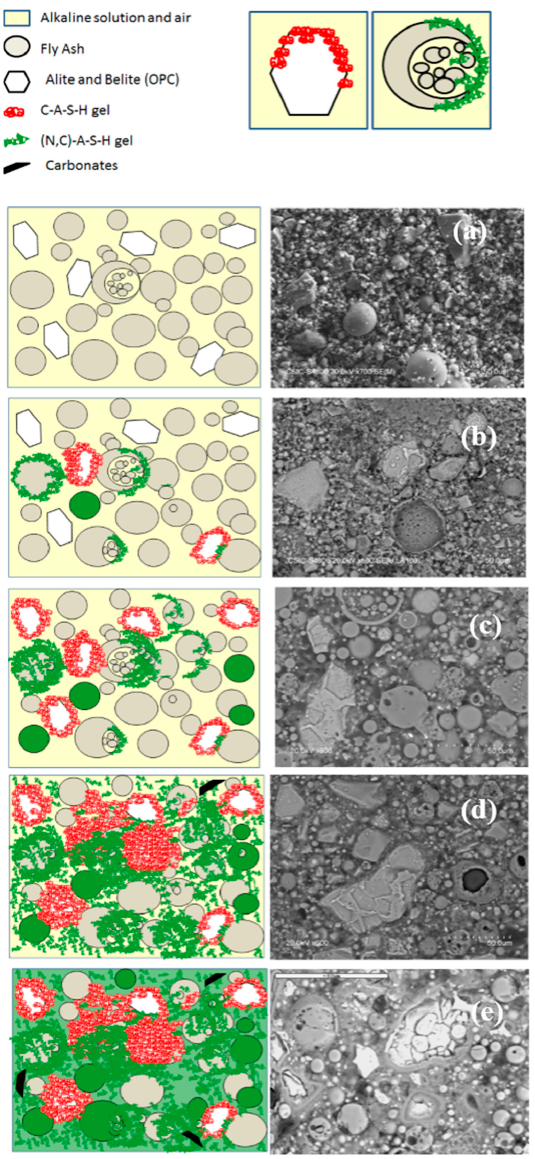
Figure 5. Changes in gel composition and microstructure of a hybrid alkaline cement with a very high fly ash content: ( a ) initial stage; ( b ) early age sample (min); ( c ) early age sample (h); ( d ) 7-day sample; ( e ) 28-day sample.